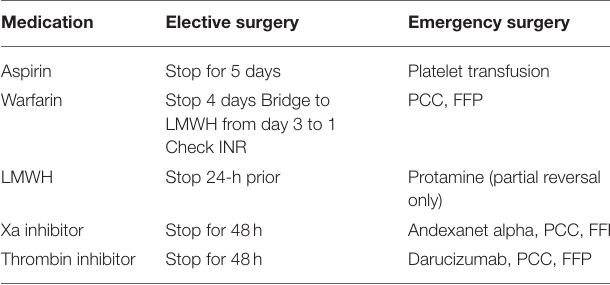
Table 5 . The risk of thrombosis should be weighed against that of excessive bleeding and should be discussed in detail with hematology, cardiology and cardiac surgery